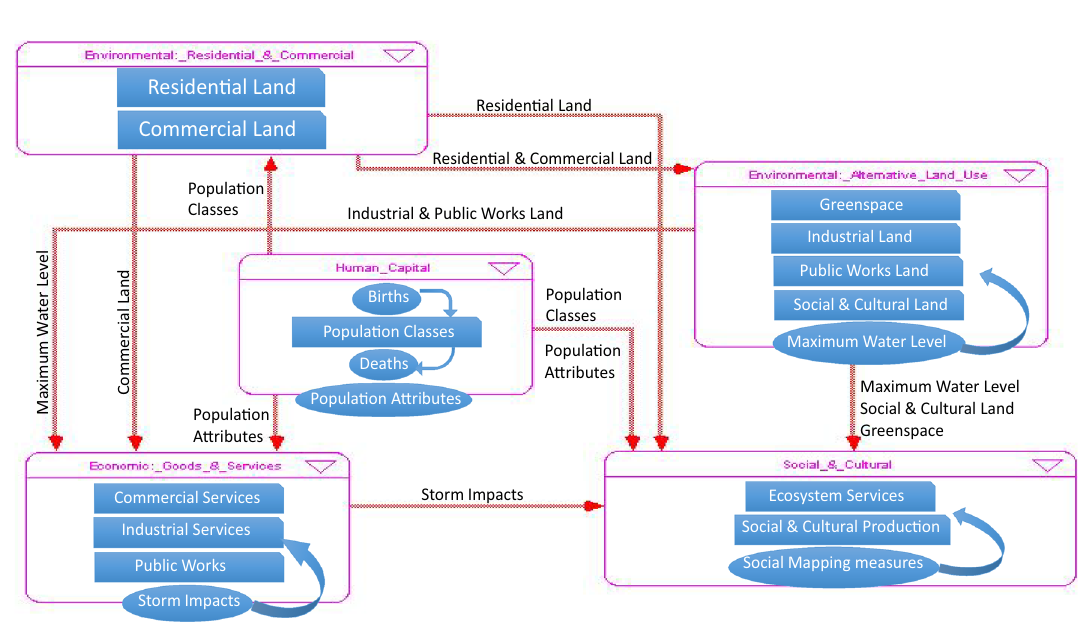
Fig. 3 System dynamics model: high-level STELLA model interfaces output. Source Modified output from STELLA (cid:3)